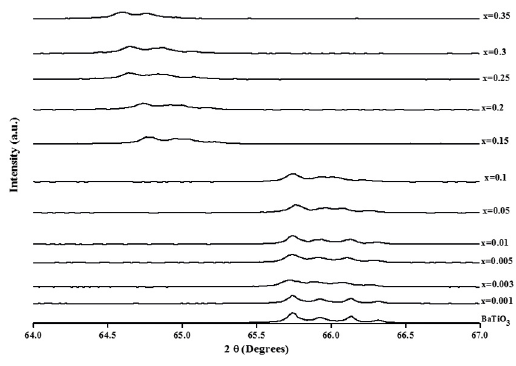
Gd Ti O powders sintered 1-x x 1-x/4 3